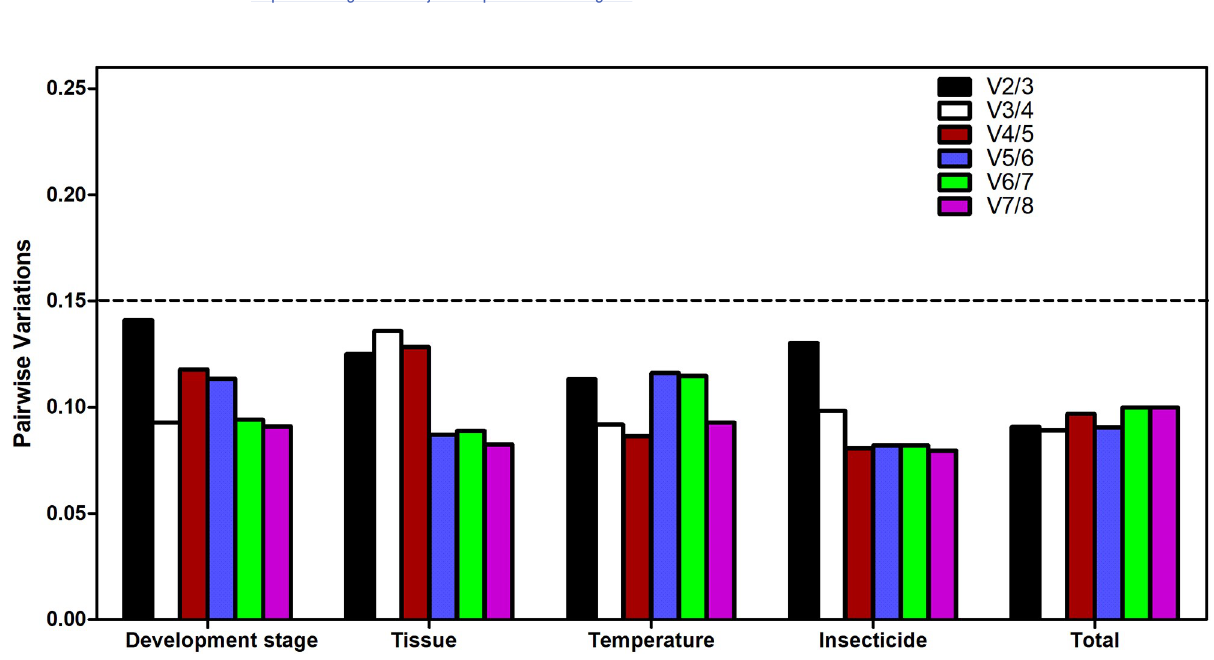
Fig 3. Optimal number of reference genes used for normalization of gene expression by geNorm program. A value of pairwise variation (Vn/Vn+1) below 0.15 suggested that no extra gene was required for normalization of gene expression in this condition.